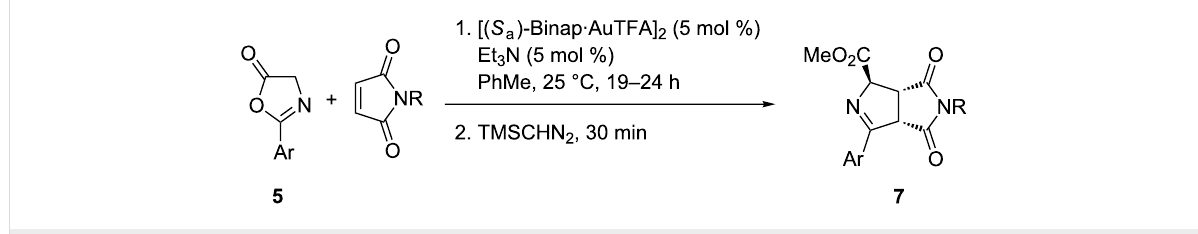
Scheme 2: General 1,3-DC between azlactones 5 with maleimides.